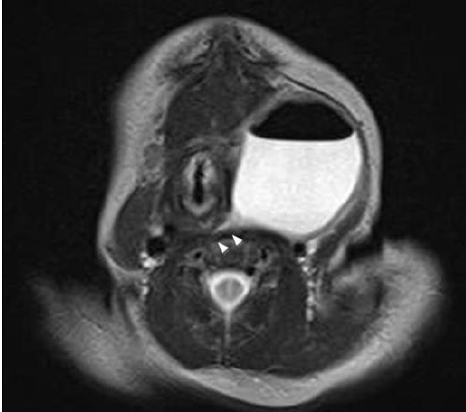
Figure 2: Neck MRI Findings(T2): A 4 × 4 × 3.7 cm size well-defined unilocular cystic mass in the left infrahyoid neck. An internal air-fluid level with suspected fistulous tract at the level of the left pyriform sinus and an infero- medial beak at the level of the cervical esophagus is shown.